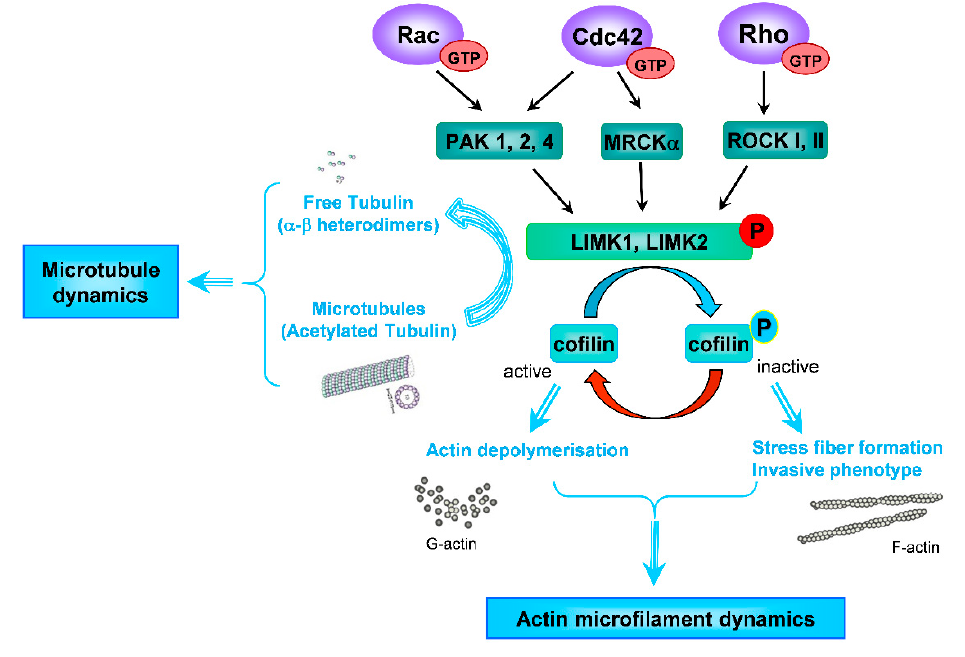
Figure 1. LIM Kinase signaling pathway.